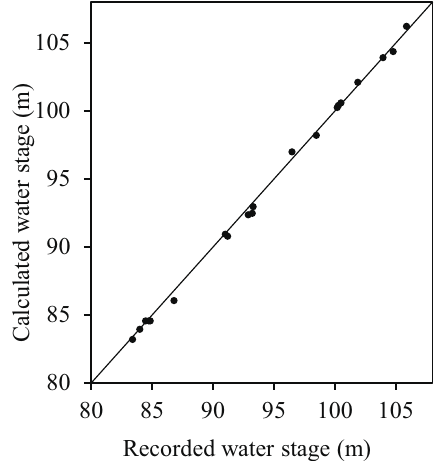
Figure 9. Comparison of calculated and recorded flood stages in Tokyo datum. The straight line shows the perfect-agreement line, i.e., recorded water stage = calculated water stage (Tsubaki et al.,